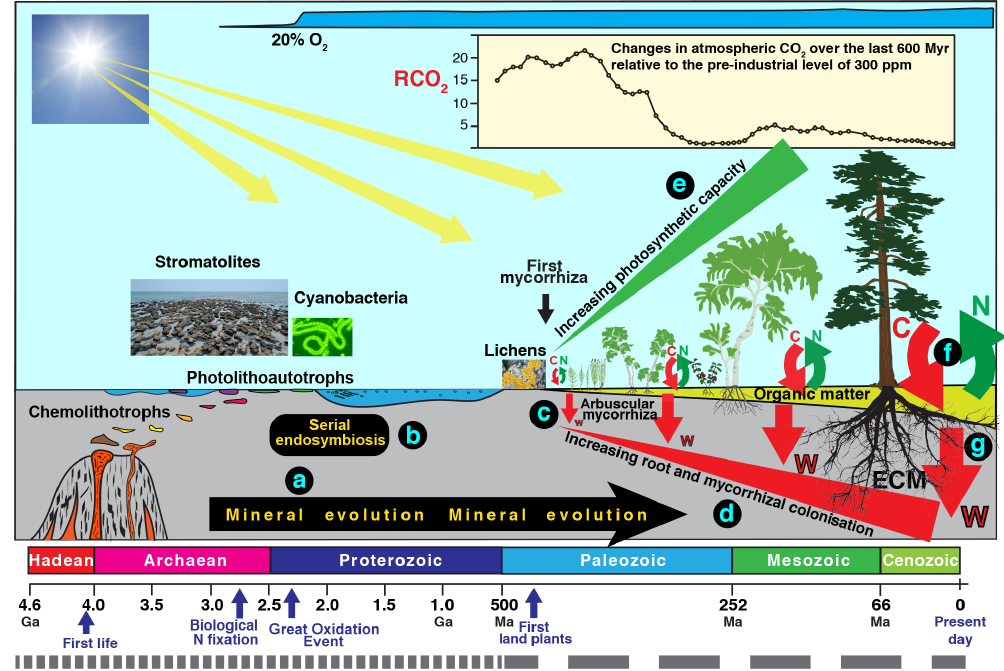
Figure 3. Schematic diagram summarising an evolutionary perspective of interactions involving mineral weathering and decomposition. Current rates of mineral weathering have been influenced by different “events” and processes, including the effects of biological processes on mineral evolution (a), serial endosymbiosis (b) enabling the evolution of higher plants, and mycorrhizal symbiosis (c) enabling increasing colonisation of substrates by roots and mycorrhizal mycelium (d), leading to more efficient nutrient uptake and larger amounts of photo- synthetic tissue (e). The evolution of ectomycorrhizal fungi (ECM) has enabled efficient extraction of N and P from recalcitrant organic material (f) powered by higher C allocation and better colonisation of organic and mineral substrates (f, g). Note the timescale of the most recent 500 million years is expanded by a factor of approximately